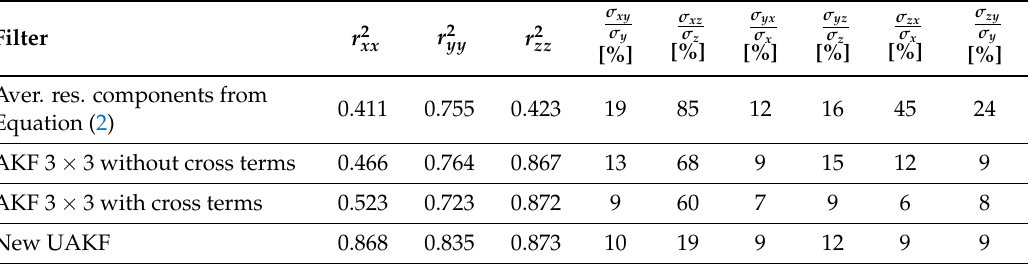
Table 2. Adequacy of filtered forces to the effective input forces measured by the hammer during pulse testing.